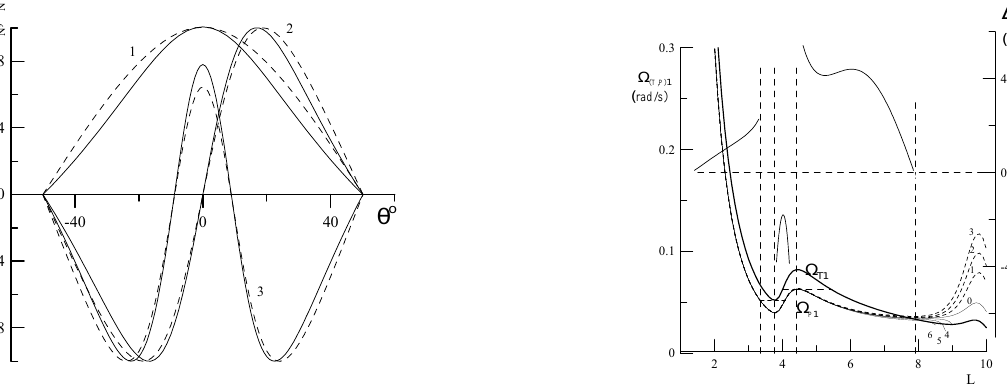
Fig. 2. The structure of standing Alfven waves with toroidal (solid lines) and poloidal polarisation (dashed lines). The curves are of the poloidal, toroidal, , eigenfunctions with unity amplitude for the first three parallel